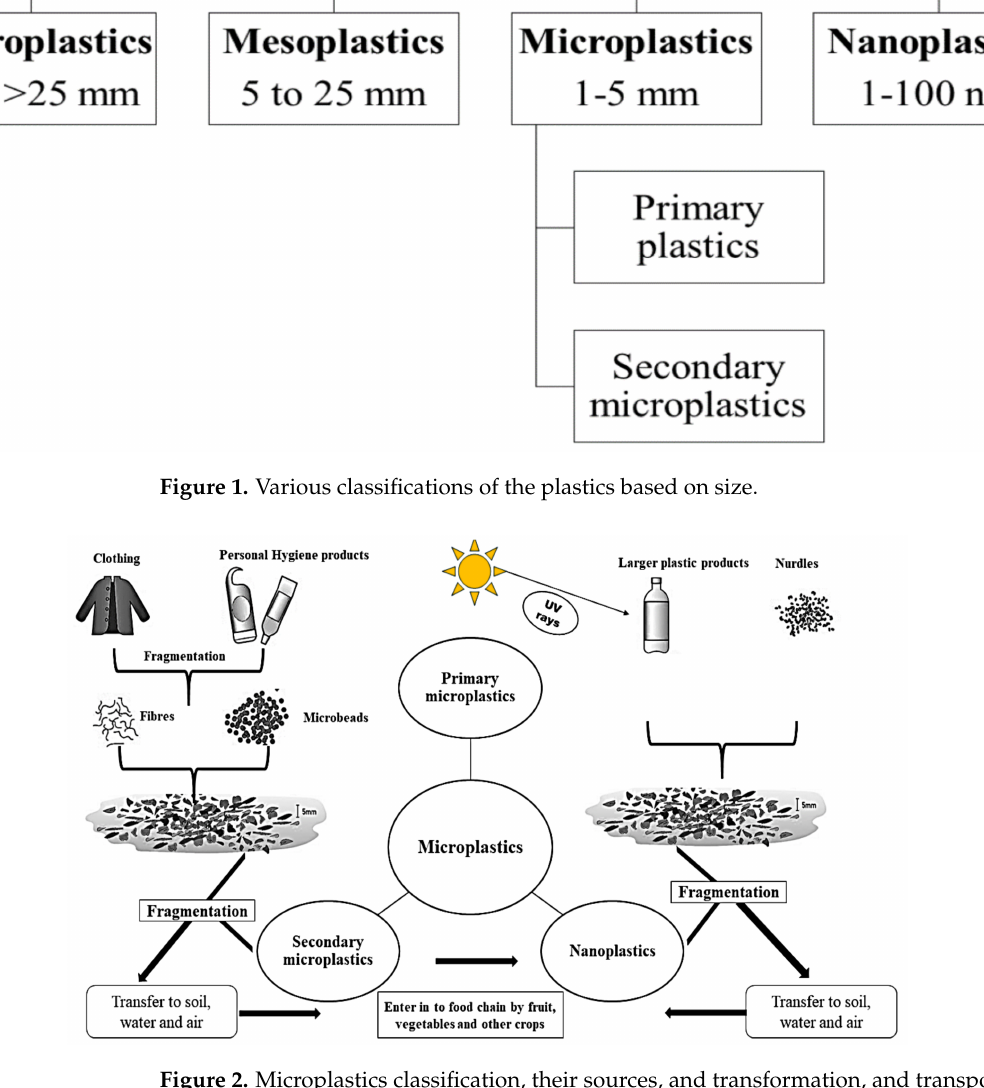
Figure 2. Microplastics classification, their sources, and transformation, and